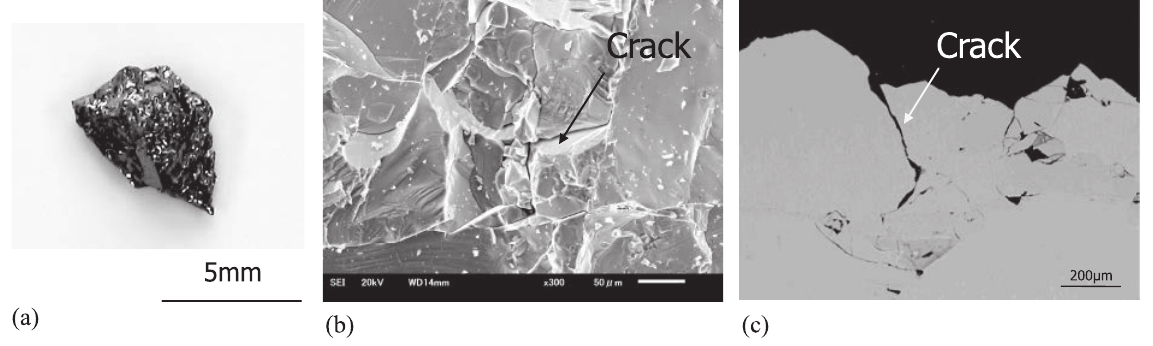
Fig. 9: The appearance (a) and a SEM image of the surface (b), and the cross-section (c) of the Fe-Ca-Si alloy. No macropores were detected, but many microcracks were observed on the surface due to the brittleness of the alloy.